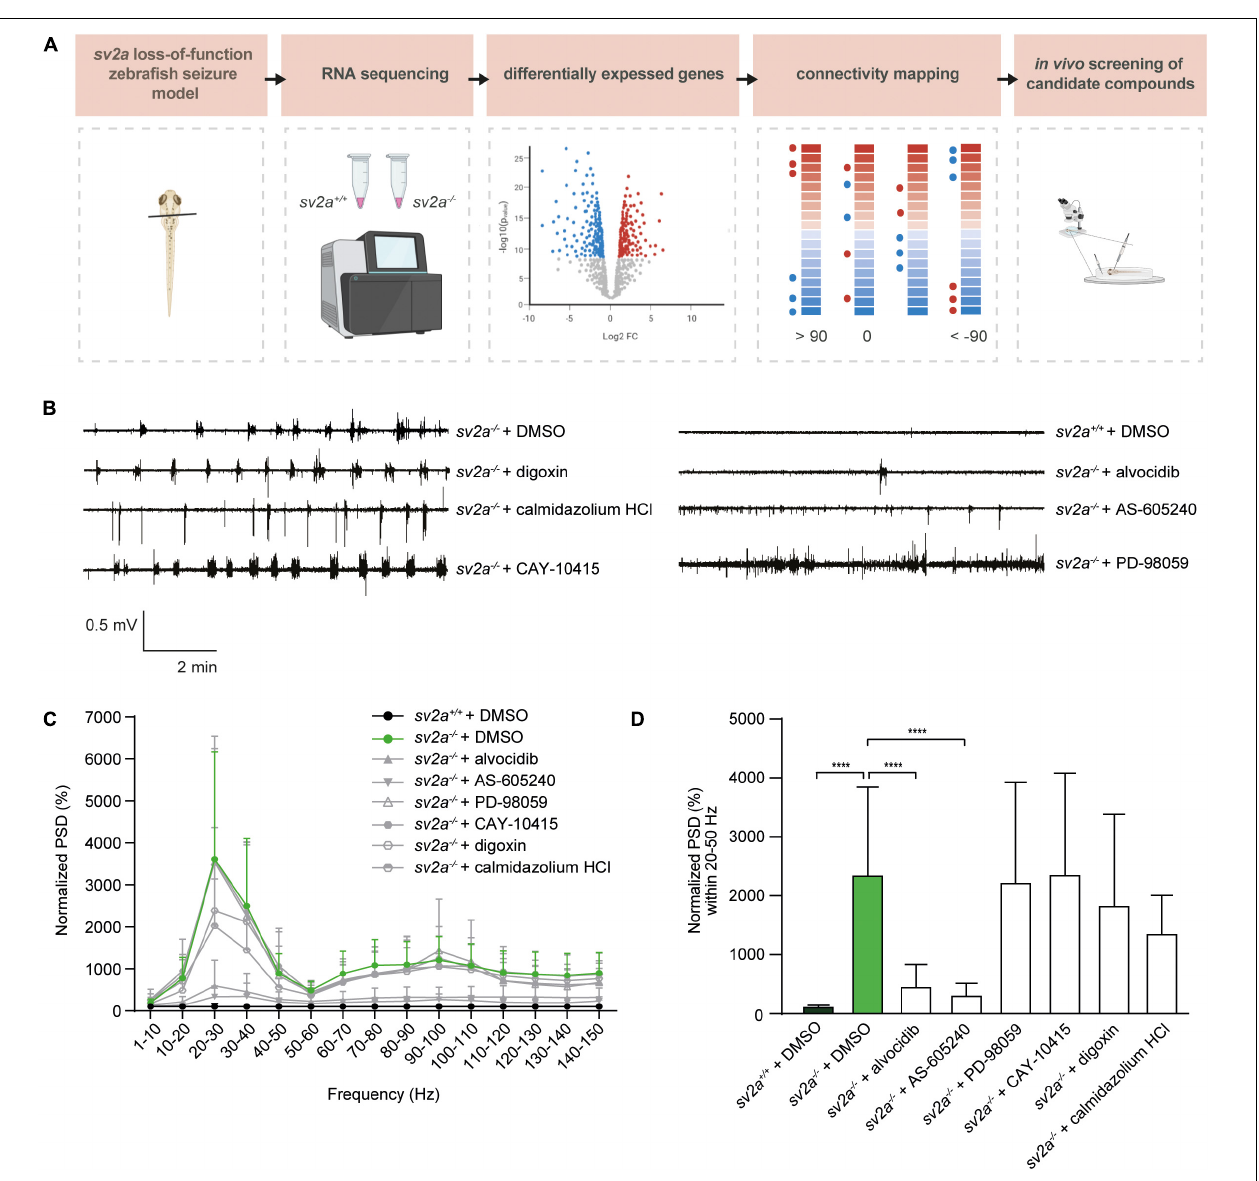
FIGURE 5 | Connectivity mapping in sv2a − / − zebrafish larvae. (A) Overview of the connectivity mapping workflow. Heads of sv2a − / − and sv2a + / + zebrafish larvae were sampled and RNA was extracted. After RNA sequencing and differential expression analysis, top 50 up- and down-regulated genes in sv2a − / − larvae (compared to sv2a + / + ) were selected based on Wald statistic and compared to gene expression profiles of compounds in the CMap database in order to identify compounds reversing the differential expression signature (scores < − 90). Three of these compounds (alvocidib, AS-605240, PD-98059) and three negative controls (scores > 90; digoxin, calmidazolium HCl, or equaling zero; CAY-10415) were tested in the sv2a loss-of-function in LFP recordings. (B) Representative LFP recordings of sv2a − / − and sv2a + / + larvae after incubation with selected CMap compounds at their MTCs or DMSO control at 5 dpf for 22 h. (C) PSD analysis of sv2a − / − and sv2a + / + larvae after incubation of selected CMap compounds at their MTCs or DMSO control at 5 dpf for 22 h. Results were normalized to sv2a + / + larvae as 100%. Number of larvae per condition: n = 9–27. (D) Power spectral density (PSD) values (mean ± SD) from LFP recordings at 6 dpf plotted per condition over the 20-50 Hz region for sv2a − / − and sv2a + / + larvae after incubation of selected CMap compounds at their MTCs or DMSO control at 5 dpf for 22 h. Number of larvae per condition: n = 9–27. Data are presented as mean ± SD. Statistical analysis was performed using ordinary one-way ANOVA. *** p < 0.001, **** p < 0.0001.